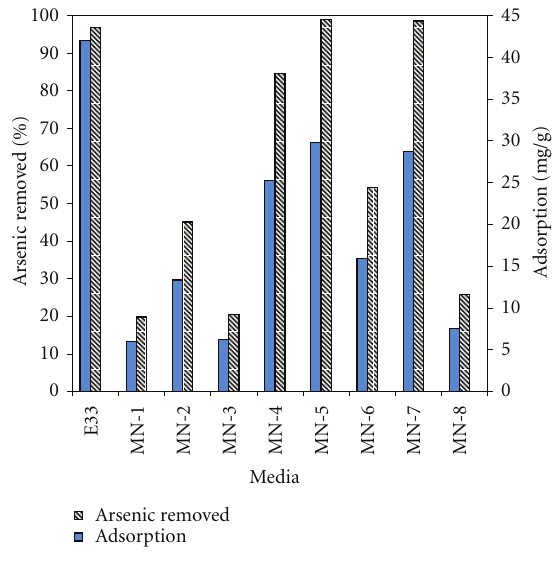
Figure 11: Arsenic adsorption study